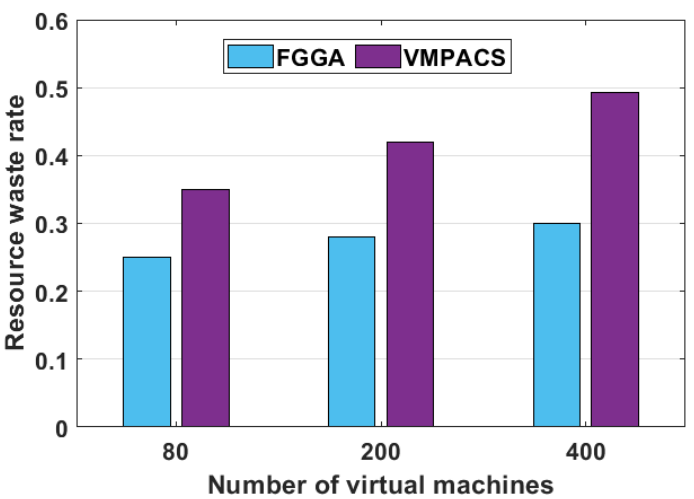
Figure 11. Comparison of average resource